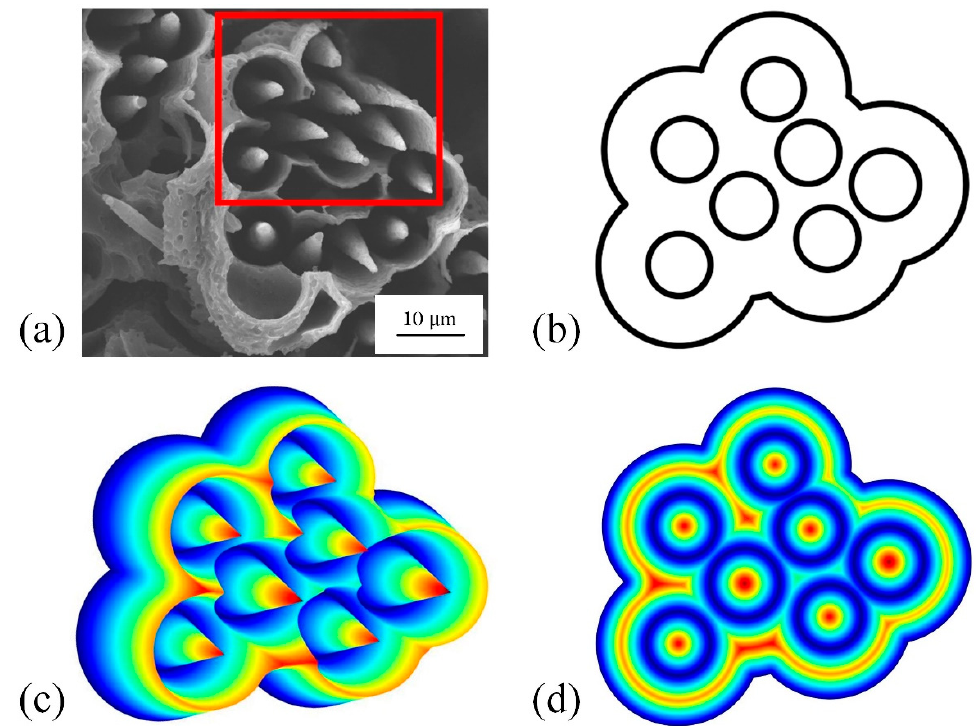
Figure 11. Comparison of experimental observation with the steady-state ablation morphology of C/C composites: ( a ) SEM morphology of C/C composite (reprinted/adapted with permission from Hindawi, 2017 [31]); ( b ) C/C composite section; ( c ) C/C composite morphology by calculation; ( d ) equipotential map of the C/C composite morphology by calculation.